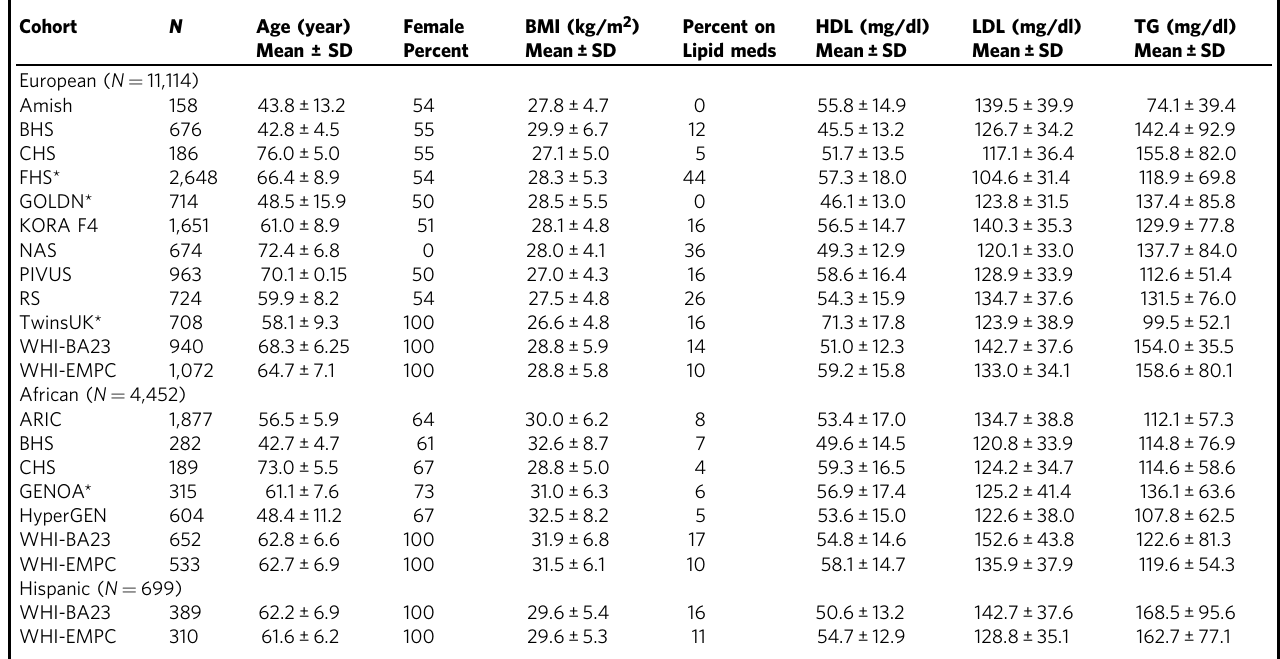
Table 1 Descriptive of the participated cohorts ( N =